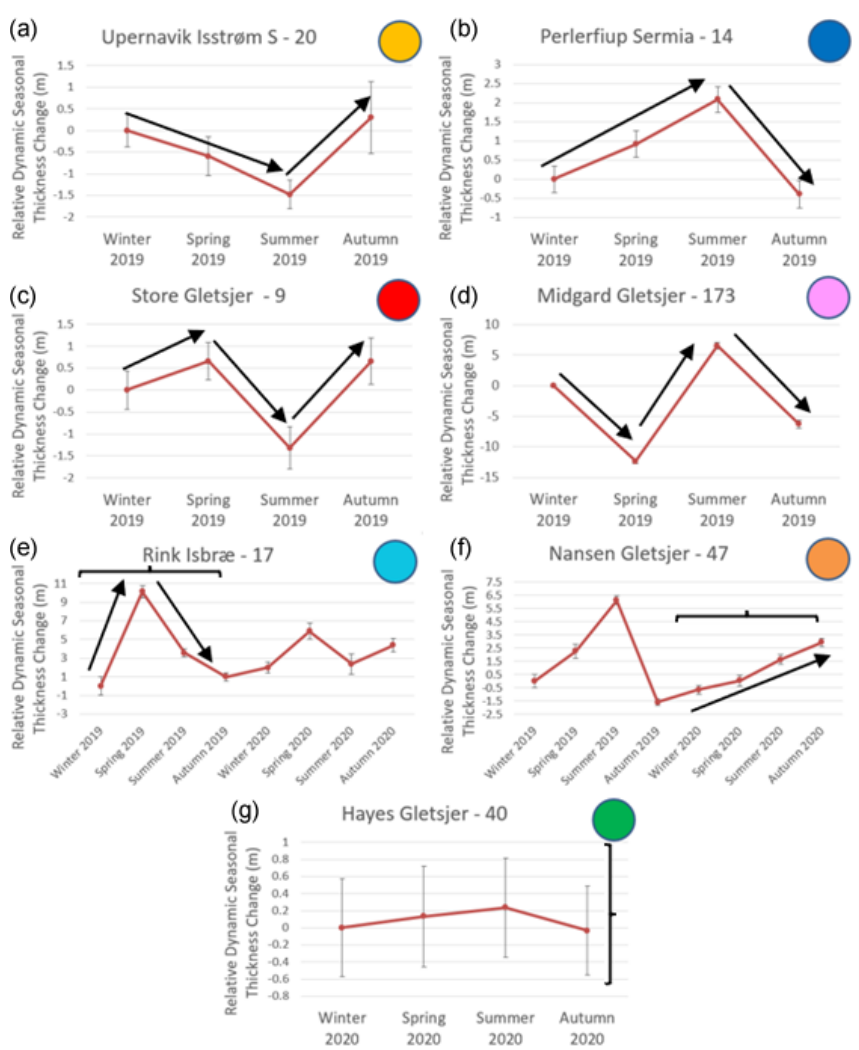
Figure 1. Patterns of outlet glacier dynamic seasonal thickness change with annual trend removed: (a) mid-year thinning, (b) mid-year thickening, (c) summer thinning with spring and autumn thickening, (d) spring and autumn thinning with summer thickening, (e) sharp single- season thickening, (f) full-year thickening, and (g) no statistically significant change. Curly brackets highlight (f) the full-year thickening pattern of Nansen Gletsjer in 2020 and (g) the extent of the error bars encompassing no seasonal change for Hayes Gletsjer. Each value plotted is relative to the first value in the time series, which is shifted to